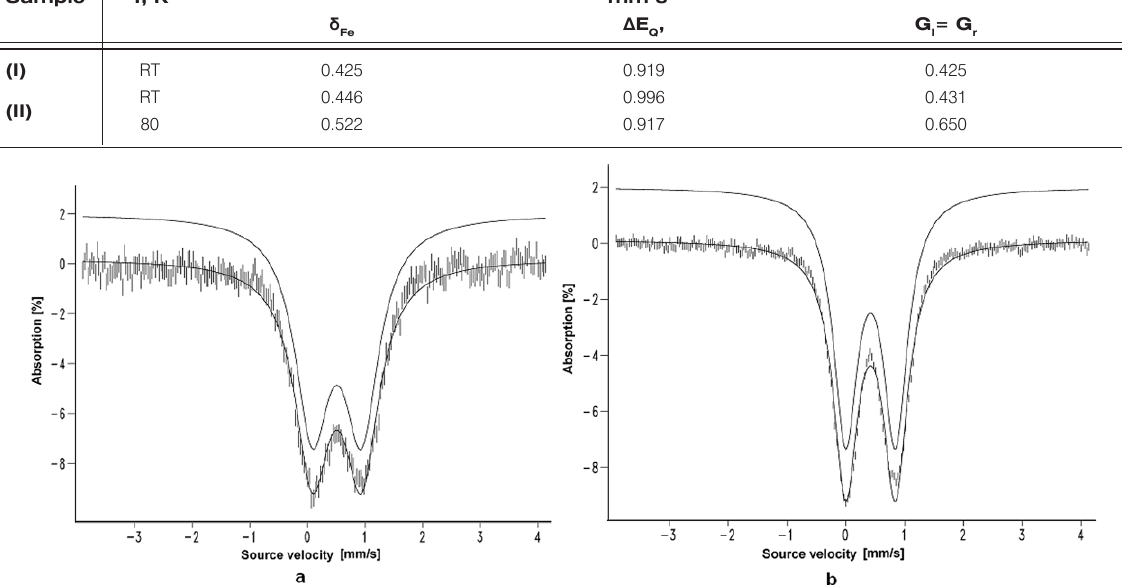
Table 3. Mössbauer data for studied clusters recorded at room temperature.